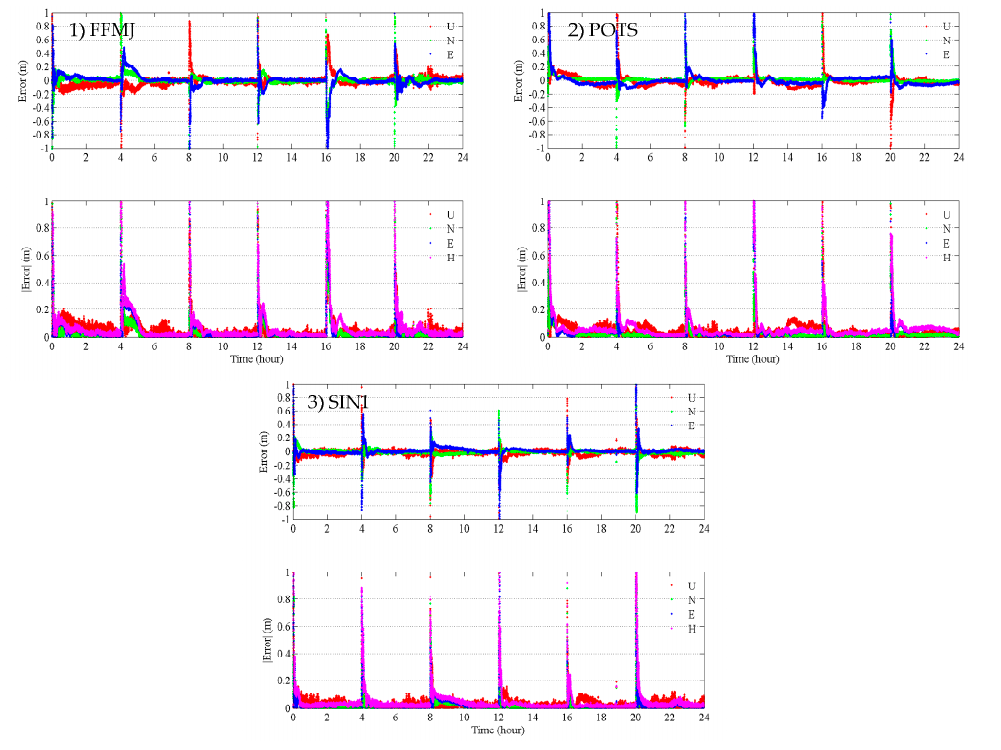
Figure 3. The error series of real-time simulated kinematic PPP in a time scale of 24 hours: ( 1 ) FFMJ; ( 2 ) POTS; ( 3 ) SIN1.